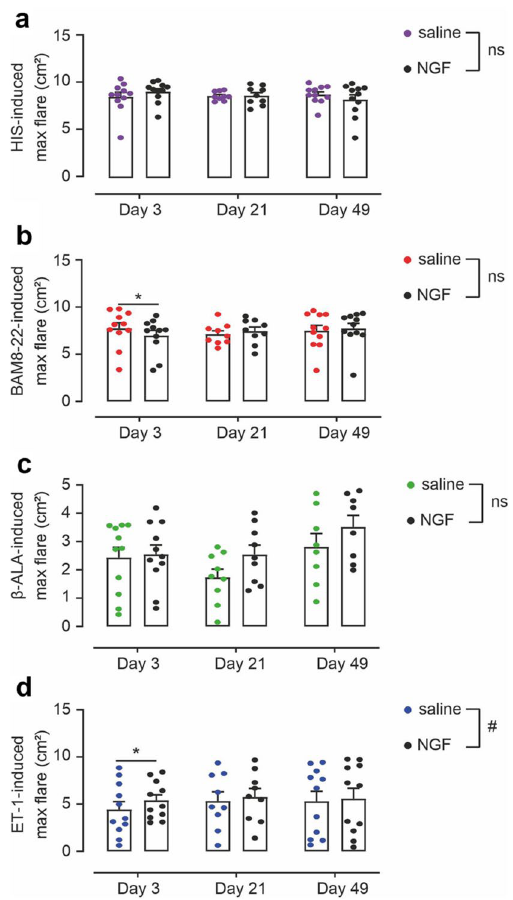
Figure 5. rhNGF has minor effects on pruritogen-induced flare responses. ( a–d ) Maximum flare responses extracted from a 5-min observation period after HIS iontophoresis ( a ) or after injections of BAM8–22 ( b ), β-ALA ( c ), and ET-1 ( d ) measured at 3 days, 21 days and 49 days post injection of rhNGF (black symbols) and saline (colored symbols), respectively. No effects of rhNGF were detected for HIS and β-ALA, respectively (n.s.). For BAM8–22, a slight rhNGF-induced flare decrease was detected at day 3 (p < 0.01, marked with asterisk), whereas ET-1-induced flare was enhanced by rhNGF (overall p < 0.03, marked by hash sign), in particular at day 3 post rhNGF (p < 0.05, marked with asterisk). Data are depicted as mean ± standard error (SEM) with overlay of individual data